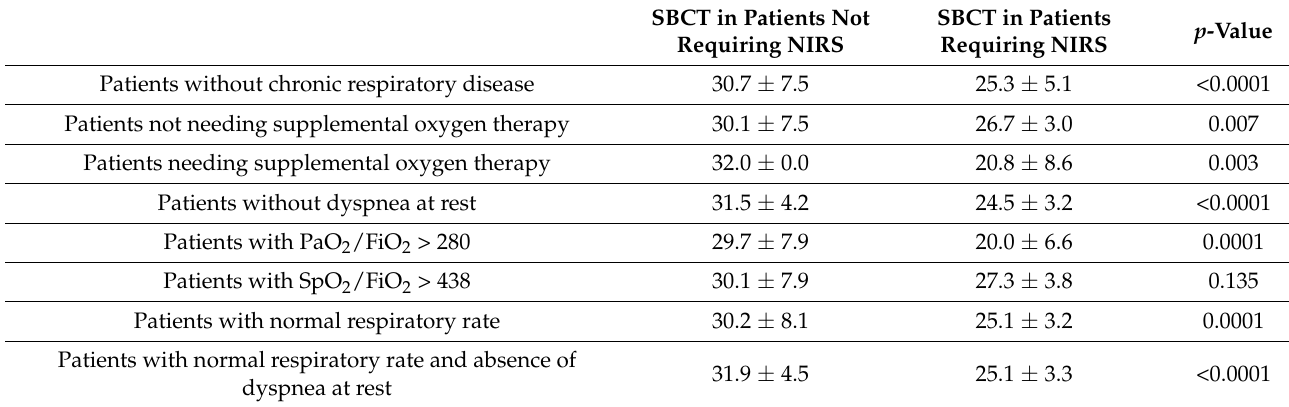
Table 3. ROC curve analysis of SBCT performance in predicting NIRS in different subgroups of patients.